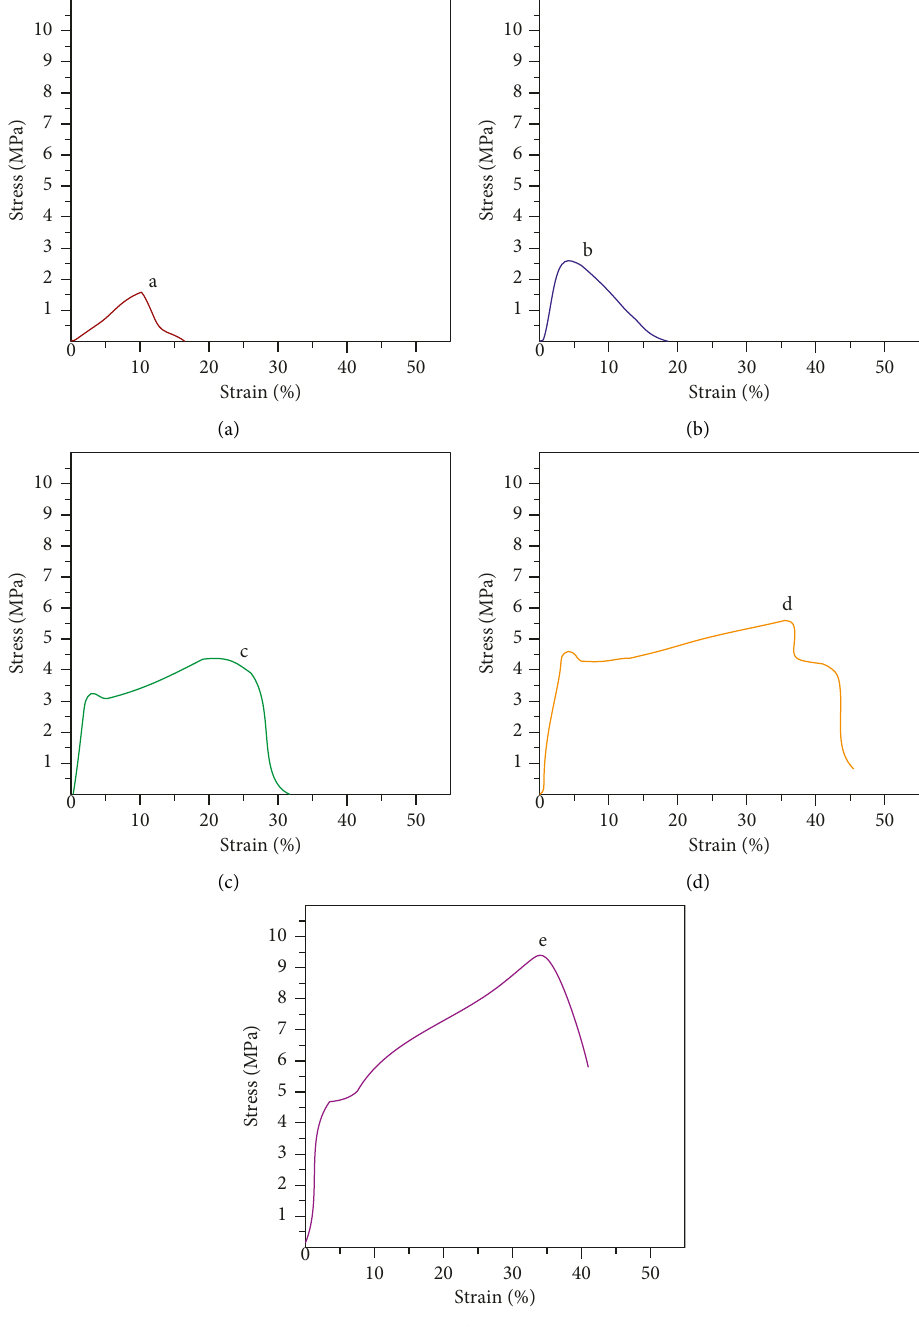
Figure 5: Tensile behavior of the SF collagen/PLLA fiber